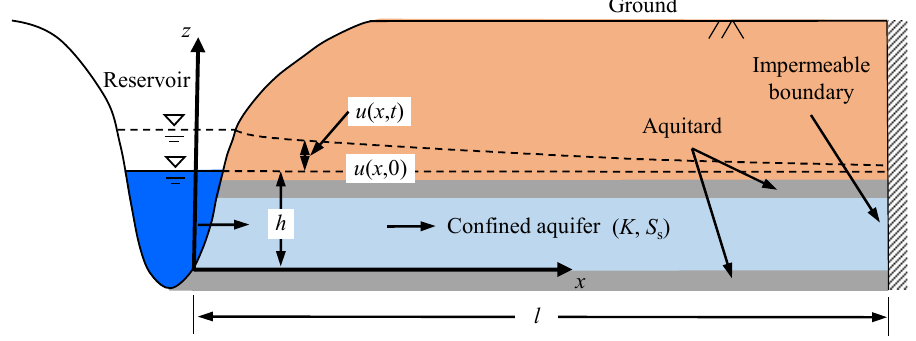
Figure 5. Schematic diagram of the hydraulic responses of the one‐dimensional confined aquifer.